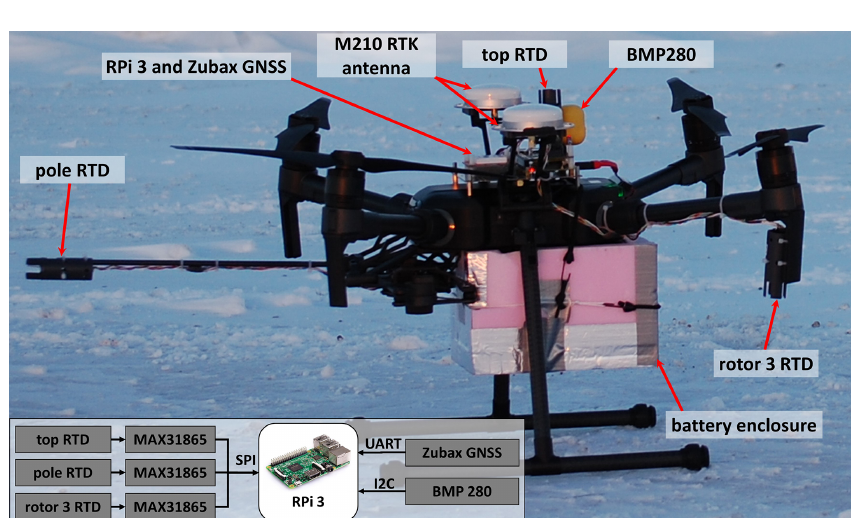
Figure 2. The DJI M210 RTK drone and its